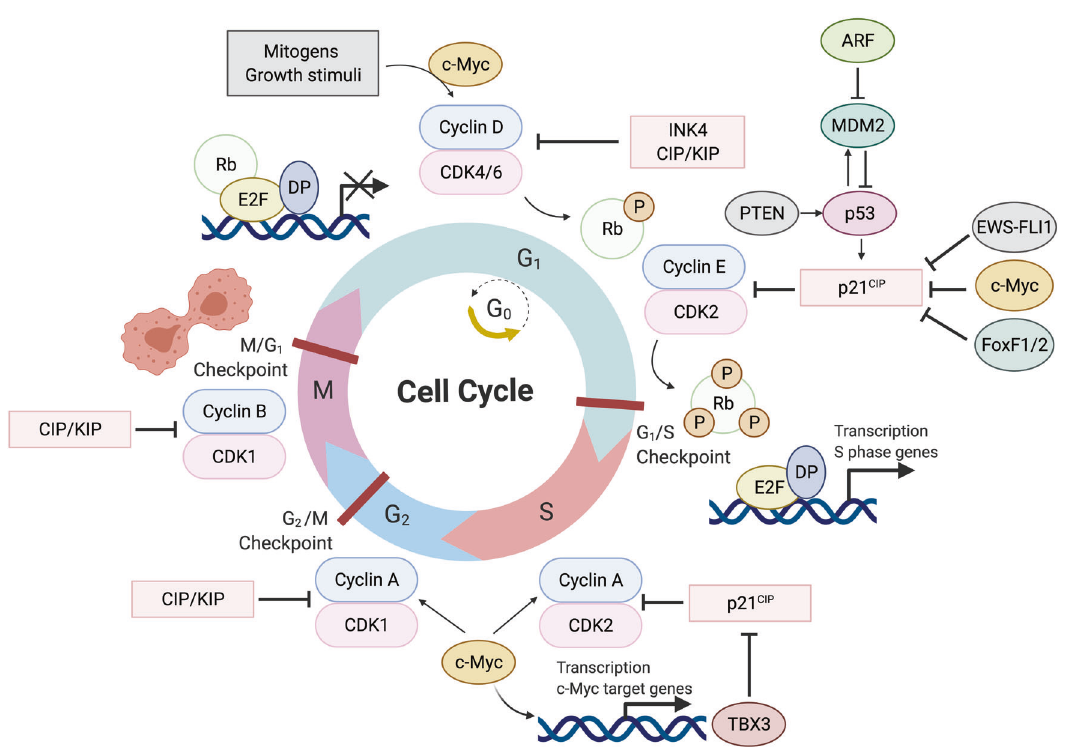
Fig. 3 Schematic illustration of the mammalian cell cycle and proteins involved in